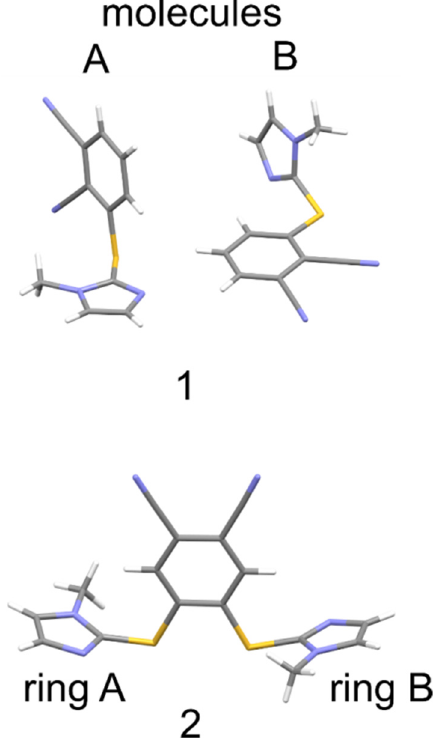
Figure 2. Crystal structures of 1 and 2. Table 1. Geometry of selected C-H ··· N and C-H ··· S interactions in 1 and 2